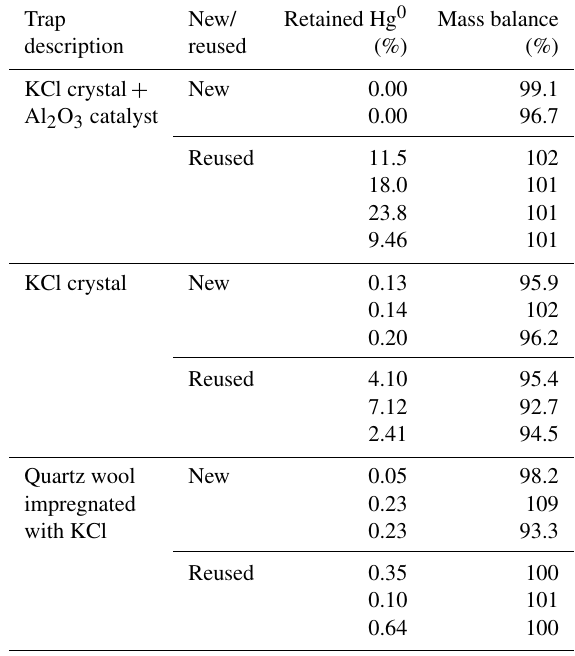
Table 1. Hg 0 retention on various KCl sorbent trap designs, and comparison of new and reused designs. Results are presented in percentage of the initially purged Hg 0 amount. Less than 1ng of Hg was